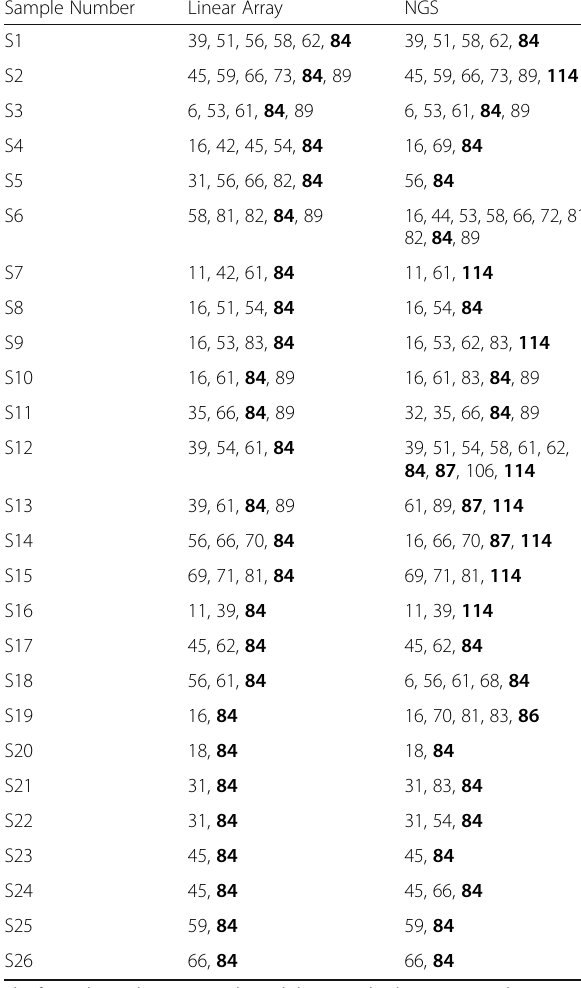
Table 1 HPV genotyping by NGS of 26 cervical samples LA HPV84+